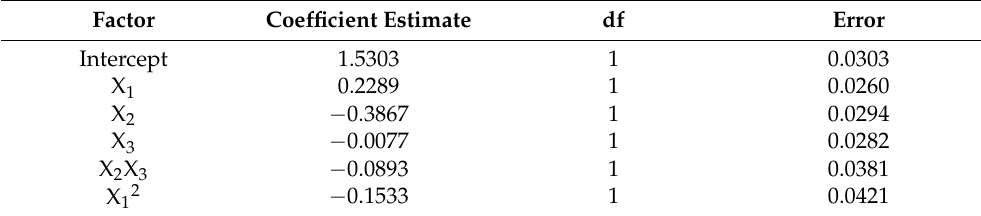
Table 4. Coefficients in terms of coded factors of the reduced quadratic resolution model, with coded factors X 1 = formic acid concentration ( v / v ) (%), X 2 = gradient slope (% min − 1 ) and X 3 = temperature ( ◦ C). Factor Coefficient